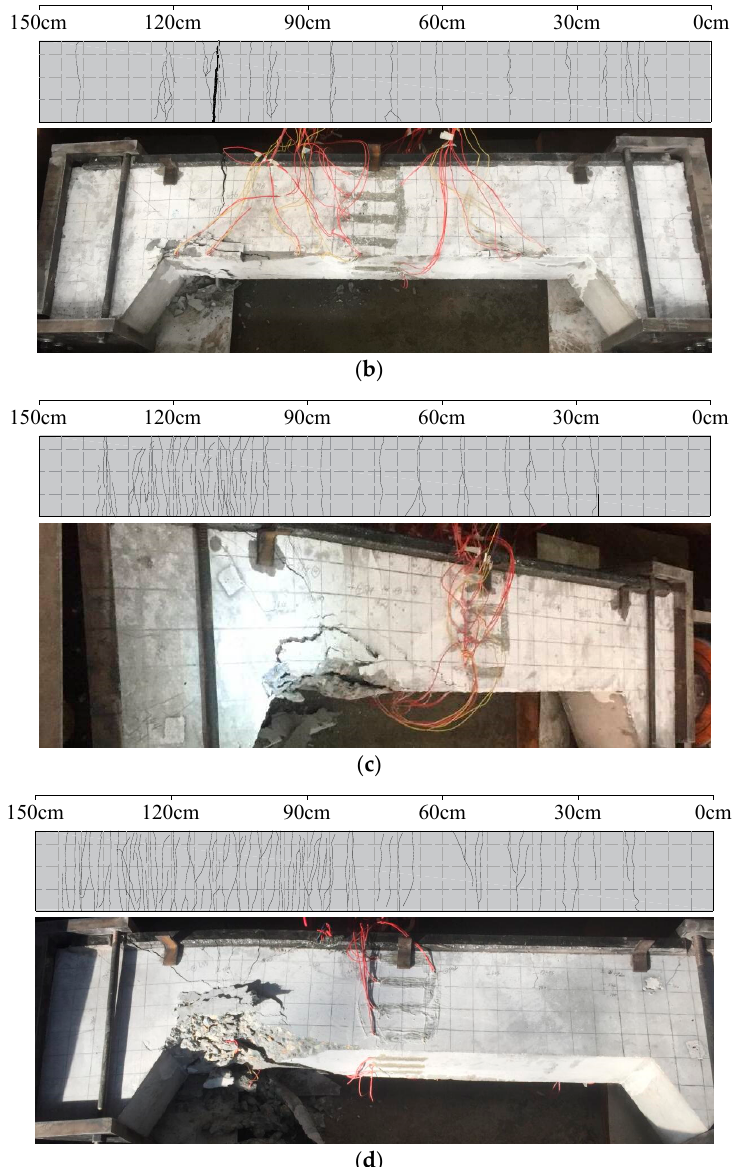
Figure 9. Crack patterns and failure modes of: ( a ) S-0; ( b ) S-1; ( c ) S-2; ( d ) S-3.